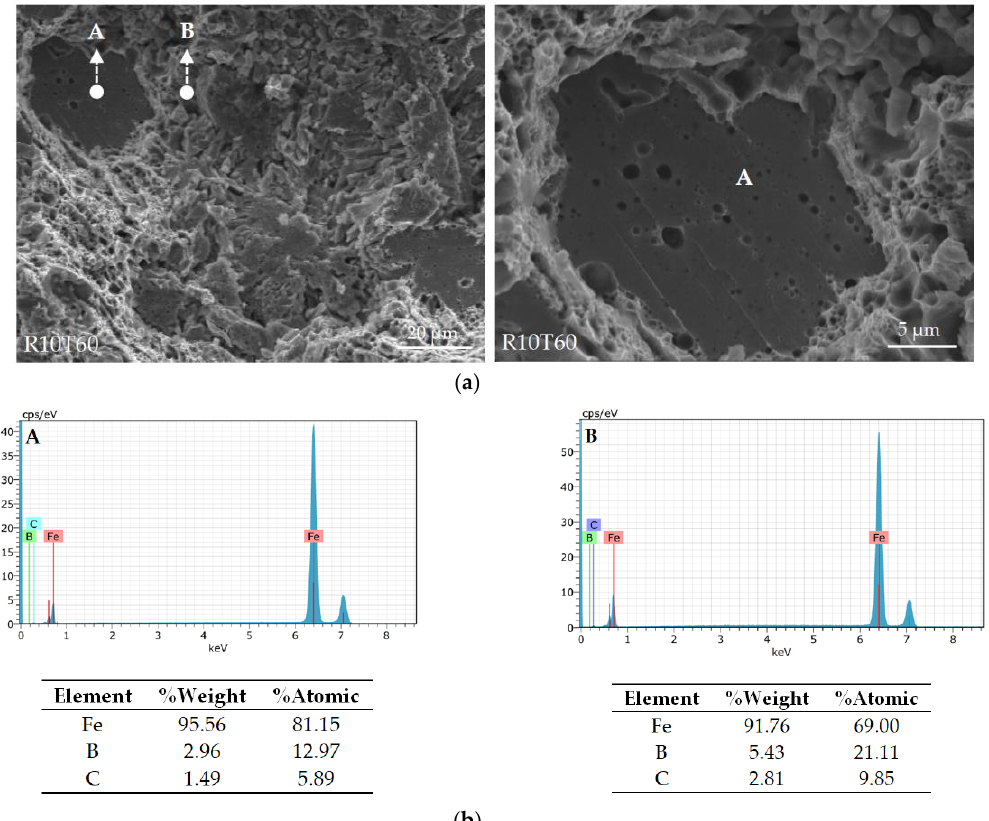
Figure 20. SEM images of fractured surfaces from the 60 min sintered Fe + 5 vol.% B 4 C test specimen, A: the magnified region of the white dashed line.